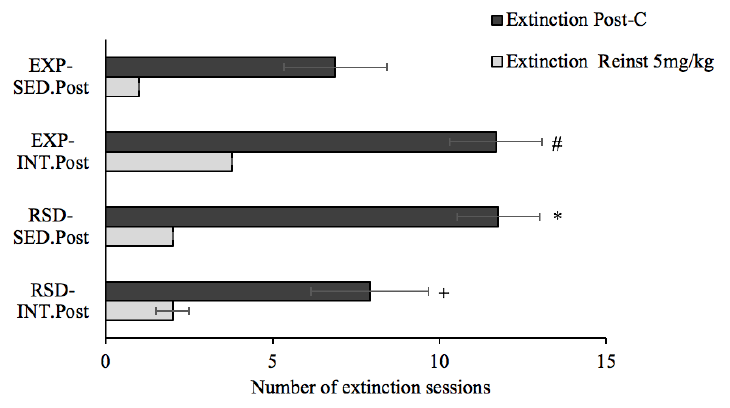
Figure 8. A dose of 10 mg/kg of cocaine induced CPP in all experimental groups. Animals were randomly assigned to the following groups according to their social-stress history and the physical- activity condition during extinction of drug-associated memories: non-stressed animals with seden- tary activity during extinction (EXP – SED.Post) or with a regiment of intermittent exercise (EXP – INT.Post); socially defeated animals with sedentary activity during extinction (RSD – SED.Post) or with a regiment of intermittent exercise (RSD – INT.Post). The bars represent the time (s) spent in the drug-paired compartment before conditioning sessions in the PRE-C test (white bars), and after conditioning sessions in the POST-C test (black bars), in the first extinction sessions (EXTINCT, light gray bars), and in the reinstatement with 5 mg/kg cocaine (REINST 5 mg/kg cocaine, dark gray bars), in the second extinction sessions (EXTINCT, light gray striped bars), and in the reinstatement with 2.5 mg/kg cocaine (REINST 2.5 mg/kg cocaine, dark gray striped bars). Data are presented as mean